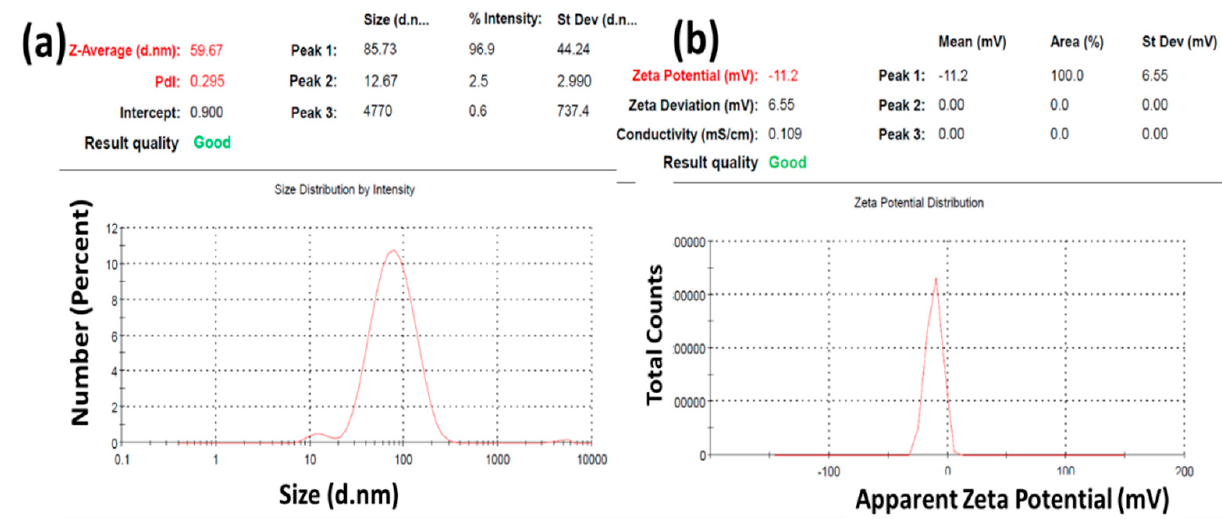
Figure 4. Characterization of rutin-SNPs for ( a ) Size, PDI; ( b ) zeta size.